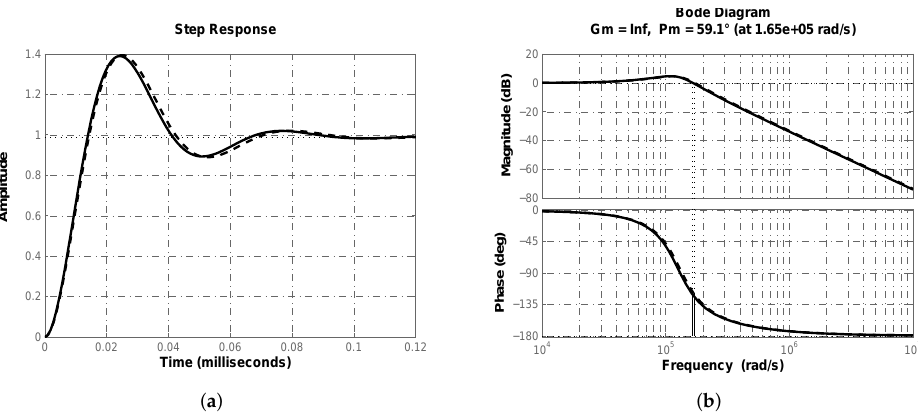
Figure 9. ( a ) Closed -loop step response of plant’s transfer function (2) with fractional-order approxi- mation (19). ( b ) Frequency response corroborating closed-loop phase margin φ d ≈ 60 ◦ . Electrical simulations allow us to determine effectiveness of the results obtained from second minimization criterion J 2 . Figure 10 shows converter output voltage v o ( t ) , inductor current i L ( t ) and control law ¯ d ( t ) as in the previous case. Smooth convergence of converter output voltage and inductor current that corroborates continuous conduction mode are shown in Figure 10a. Evolution of control law to its average value and the corresponding effect on the PWM signal are shown in Figure